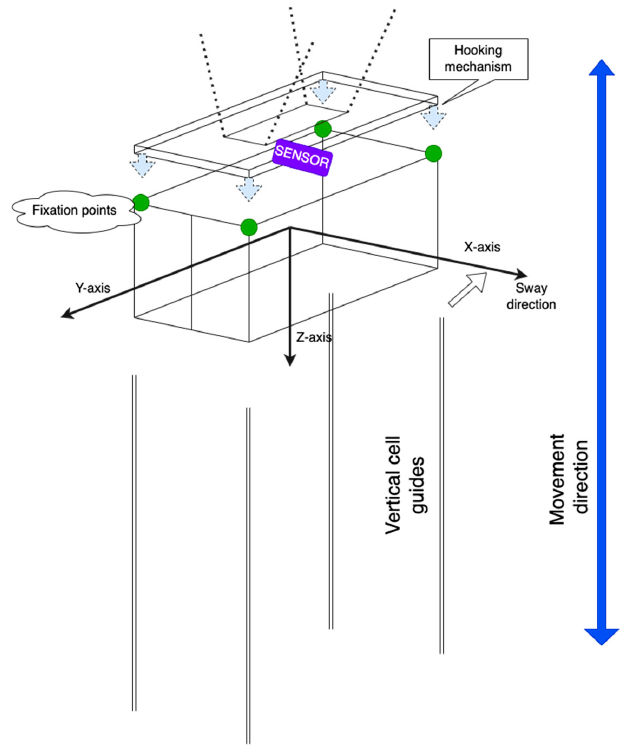
Figure 8. Schematics of the container movement trajectory during experimental case studies. Magnets and straps held the sensory gadget in place on the spreader of the chosen QC in a secure location (bottom section of Figure 7). From the spreader's first vertical movements up until its final position, data was gathered by the digital accelerometer. In- side the ship's hull, containers are stacked one on top of the other. The container's move- ment along the ship's hull is indicated by the Y-axis. Throughout the whole handling pro- cess, the container is primarily moved along the X-axis due to natural causes (mechanical and structural). 3. Results Firstly, the standardized input parameters of the IDM include [3] (starting point): •